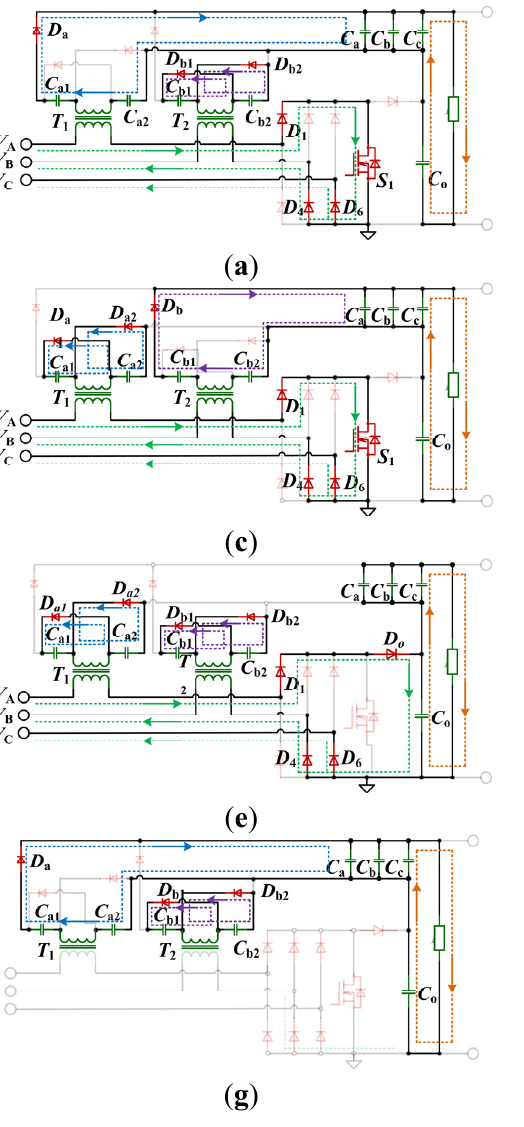
Figure 11. Key waveforms of the proposed converter.